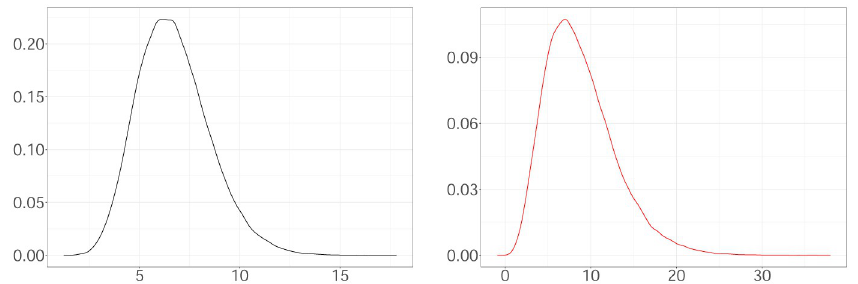
Fig 1. The generation interval (GI) (black curve) and the period between observed and actual infection times (red curve).